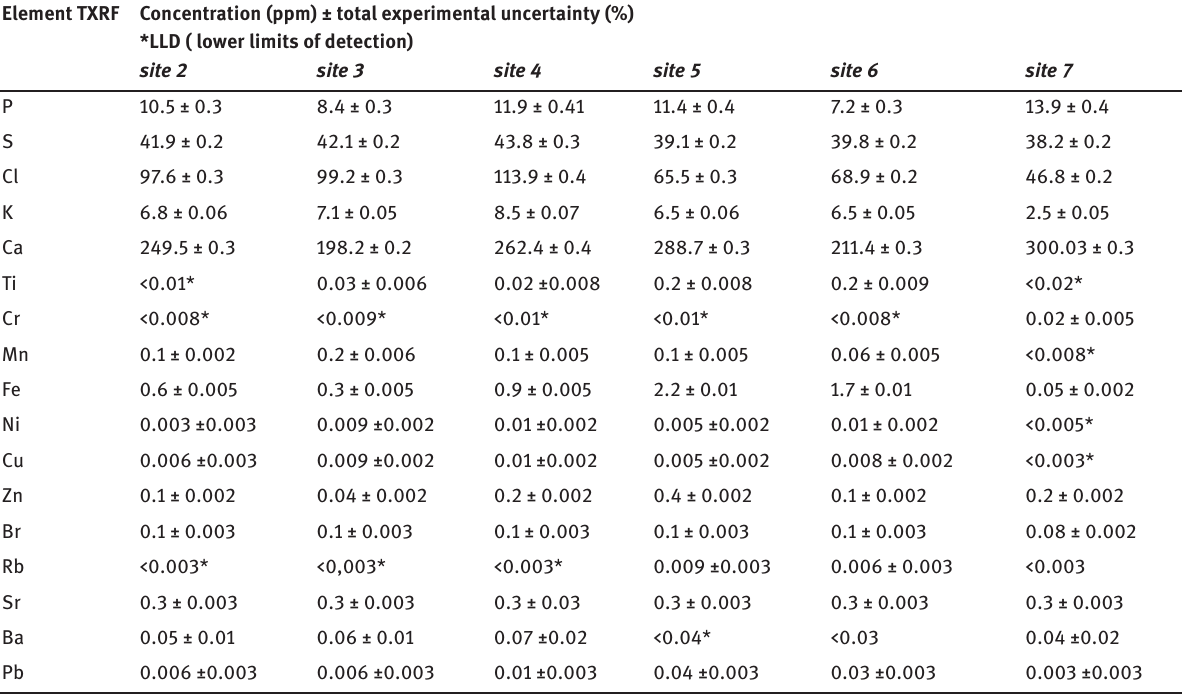
Table 2: Element concentrations in two water reservoirs A (sites 2-4) and B (sites 5-6), and drainage ditch C (site 7) determined by TXRF method in ppm units with total experimental uncertainty (in %) (May 18 th of 2015). Element TXRF Concentration (ppm) ± total experimental uncertainty